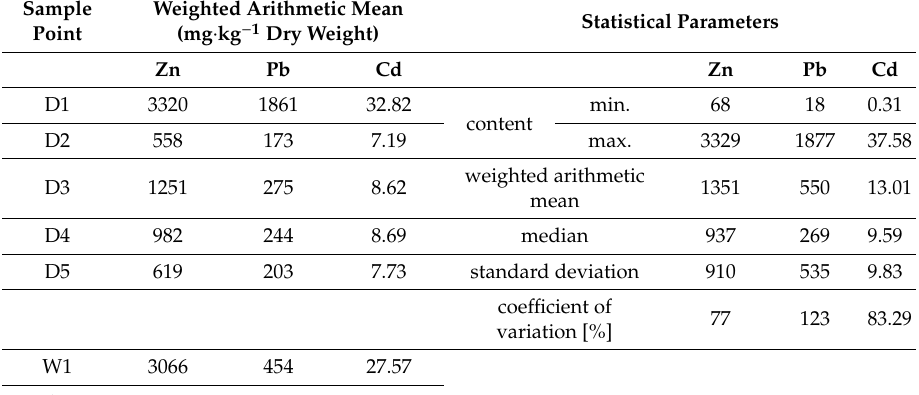
Table 2. HM concentrations in topsoil samples and baseline CB values (mg · kg − 1 dry